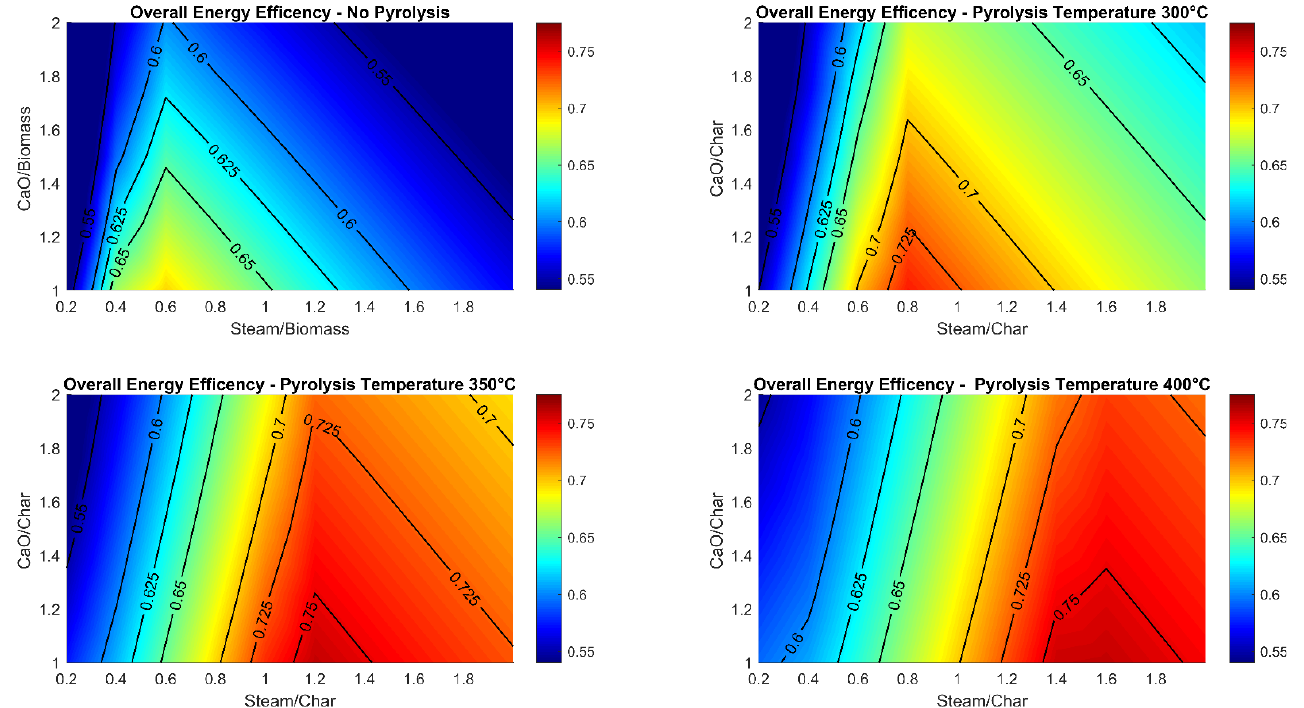
Figure 6. Overall energy efficiency as functions of the Steam/Char and CaO/Char ratios.